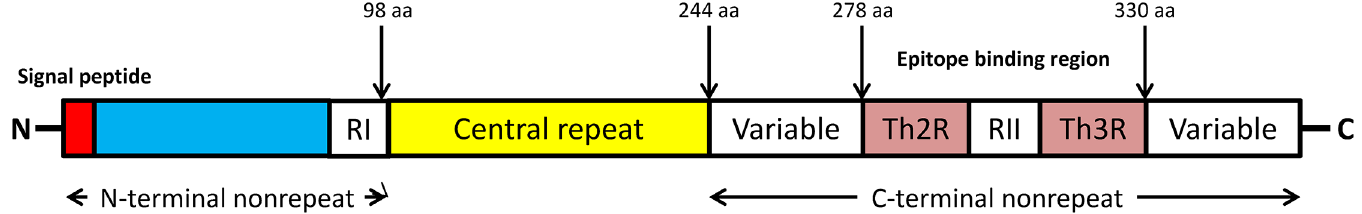
Fig 1. Structure of P . knowlesi CSP. The repeat region and the C-terminal epitope binding regions Th2R/ Th3R are based on the orthologous P . falciparum CSP. The amino acid numbering is based on the sequence of P . knowlesi strain H (GenBank Accession No. XM_002258966.1)